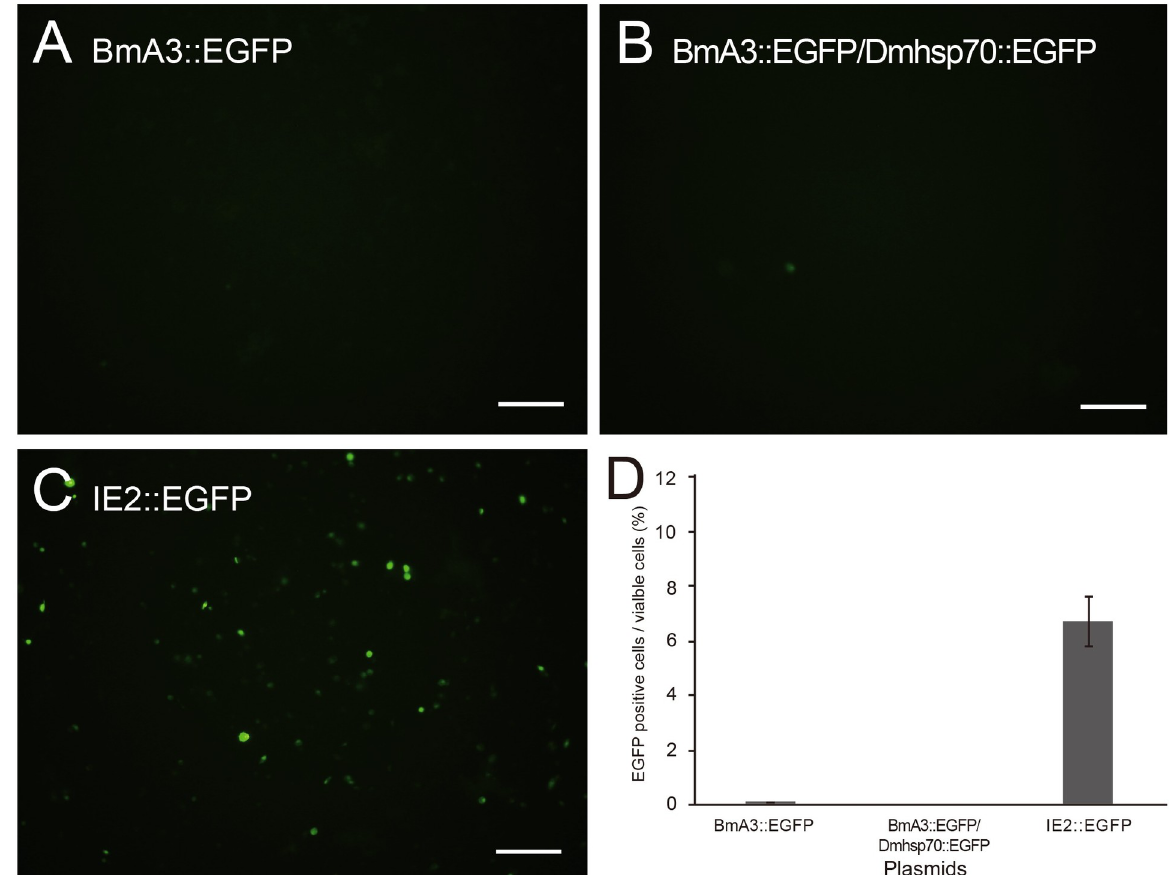
Fig 6. Induction of egfp gene expression by the introduction of expression vector plasmids into ex vivo cultured cells. Fluorescent micrographs of Day 4 cells transfected with expression vectors of A . BmA3::EGFP, B . BmA3::EGFP/Dmhsp70::EGFP, and C . IE2::EGFP. The bar indicates 100 μ m. D . EGFP fluorescence was predominantly detected in cells transfected with the IE2::EGFP vector plasmid. Error bars indicate the standard error of the mean in three replications.